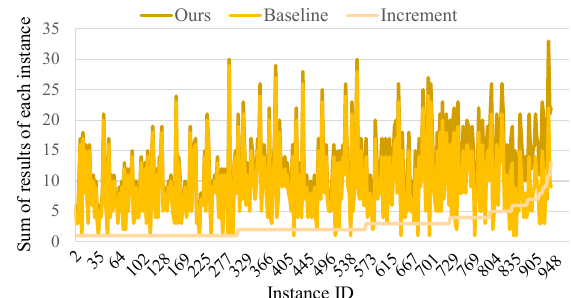
Fig. 6 Comparison of the amount of results of each instance between our model and the baseline [18]